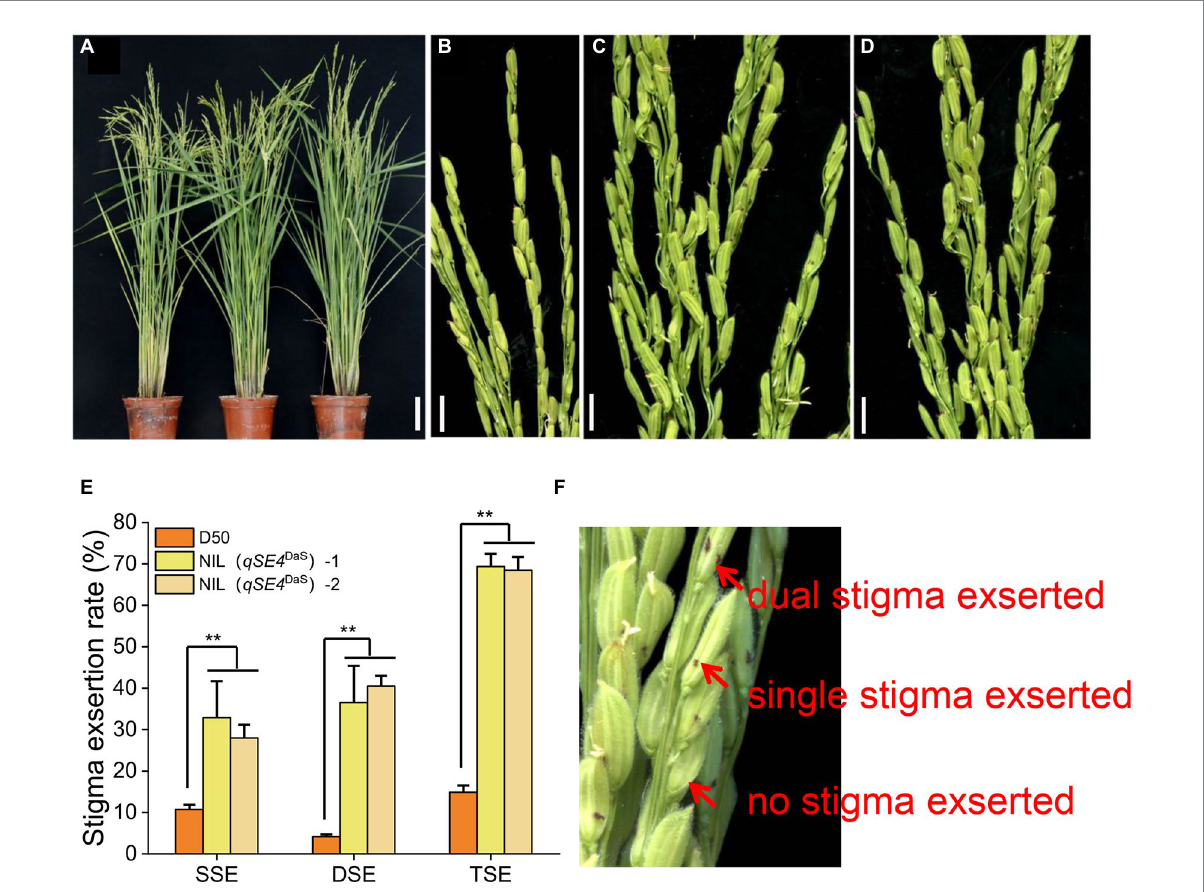
FIGURE 2 Phenotype of parental D50 and NIL. (A) D50, NIL ( qSE4 DaS )-1 and NIL ( qSE4 DaS )-2 from left to right during heading, bar = 10 cm. (B) Stigma exsertion phenotype of D50, bar = 1 cm. (C) Stigma exsertion phenotype of NIL ( qSE4 DaS )-1, bar = 1 cm. (D) Stigma exsertion phenotype of NIL ( qSE4 DaS )-2, bar = 1 cm. (E) Stigma exertion rate for D50, NIL ( qSE4 DaS )-1 and NIL ( qSE4 DaS )-2. SSE: single stigma exsertion rate, DSE: dual stigma exsertion rate, TSE: total stigma exsertion rate. (F) Stigma exsertion phenotype in rice, contains dual, single, and no stigma exsertion. The data represent the mean values ± SD ( n = 6), ** p ≤ 0.01.